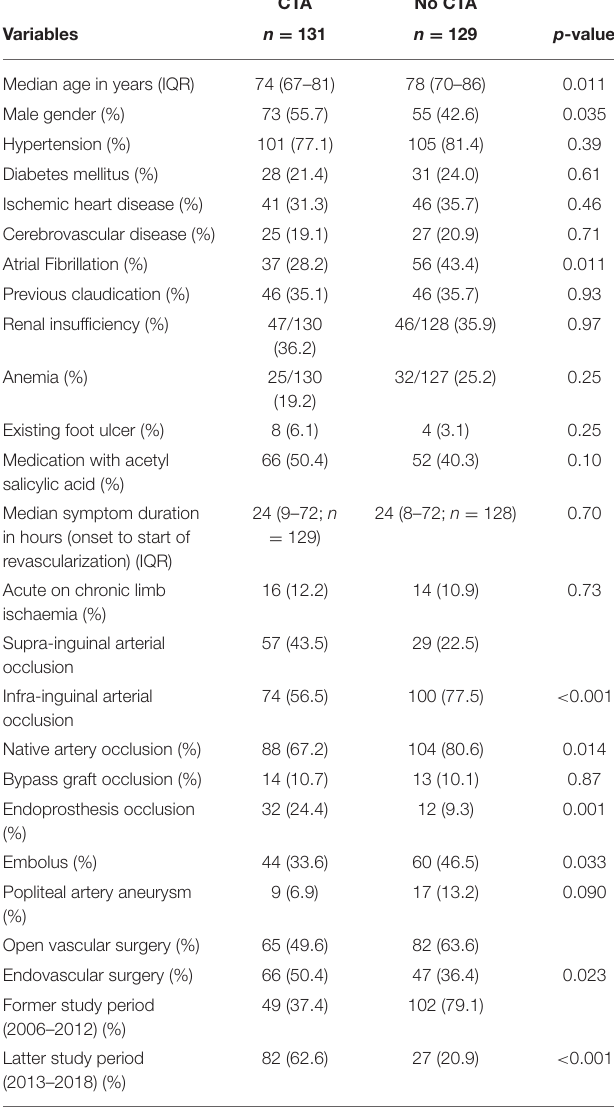
TABLE 1 | Characteristics in patients undergoing computed tomography angiography (CTA) or not prior to revascularization in patients with Rutherford IIb acute lower limb ischemia (ALI).